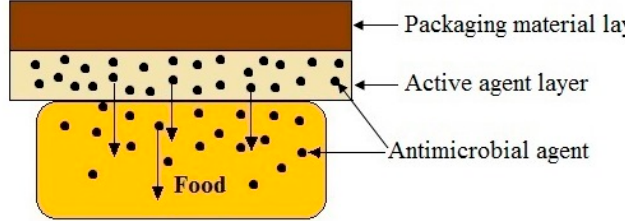
Figure 3. Releasing of antimicrobial agent from food contacting layer of multilayer packaging material.